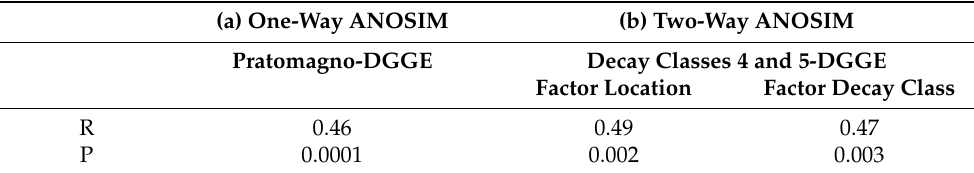
Table 2. Results of one-way ANOSIM global test conducted on DGGE profiles from the five black pine deadwood decay classes collected in Pratomagno area (a) and of two-way ANOSIM global test conducted on DGGE profiles from decay classes 4 and 5 collected in Pratomagno and Monte Morello study areas